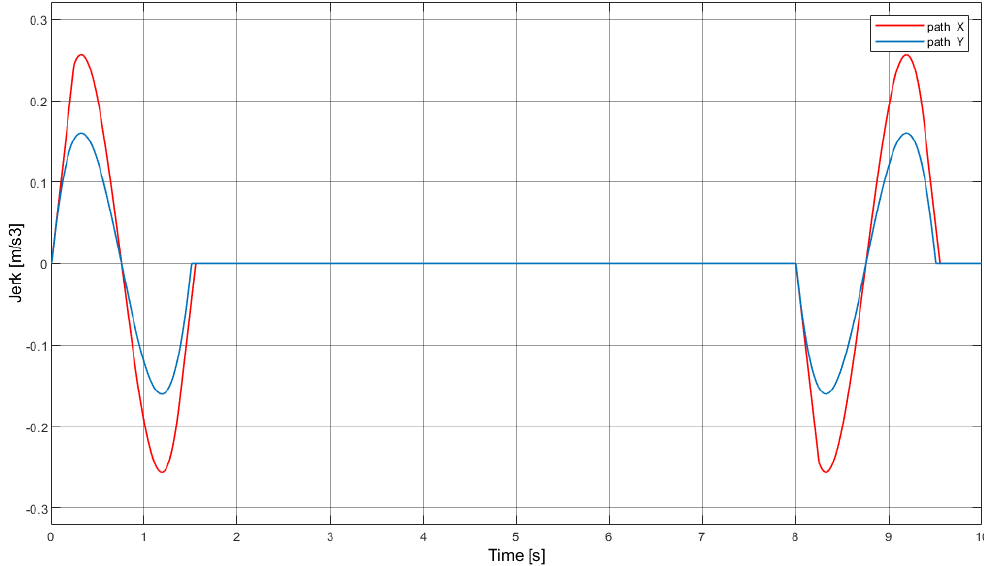
Figure 7. Trajectory for jerk using 6-1-6 polynomials for the planar CDPR.